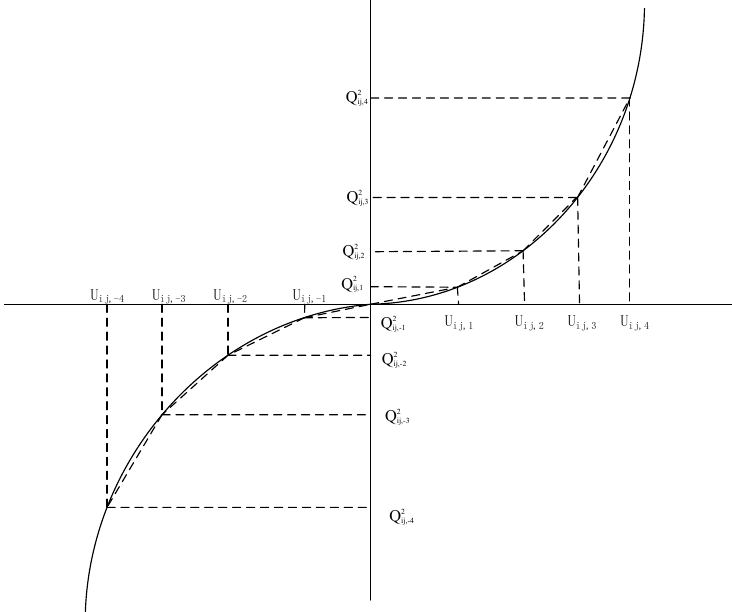
Figure 3. The diagrammatic drawing of piecewise linearization. Where U auxiliary variables which are